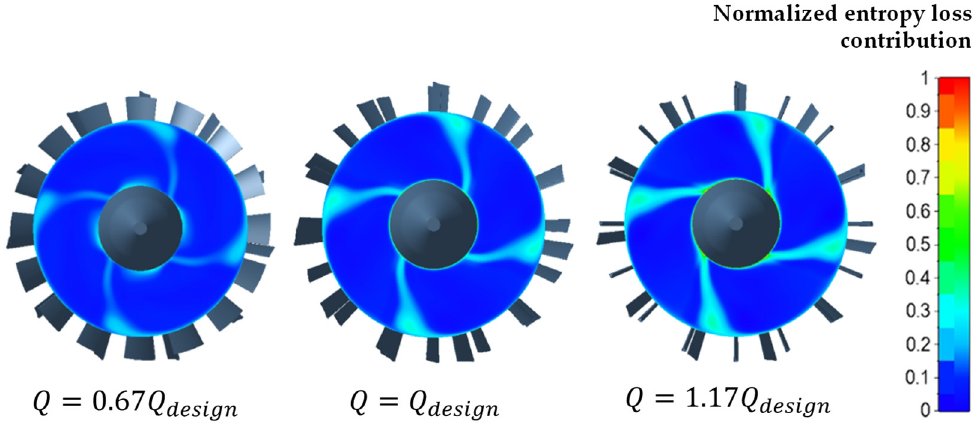
Figure 16. Normalized entropy loss contribution at a design rotational speed for three different flow rates at design rotational speed— H n = const .